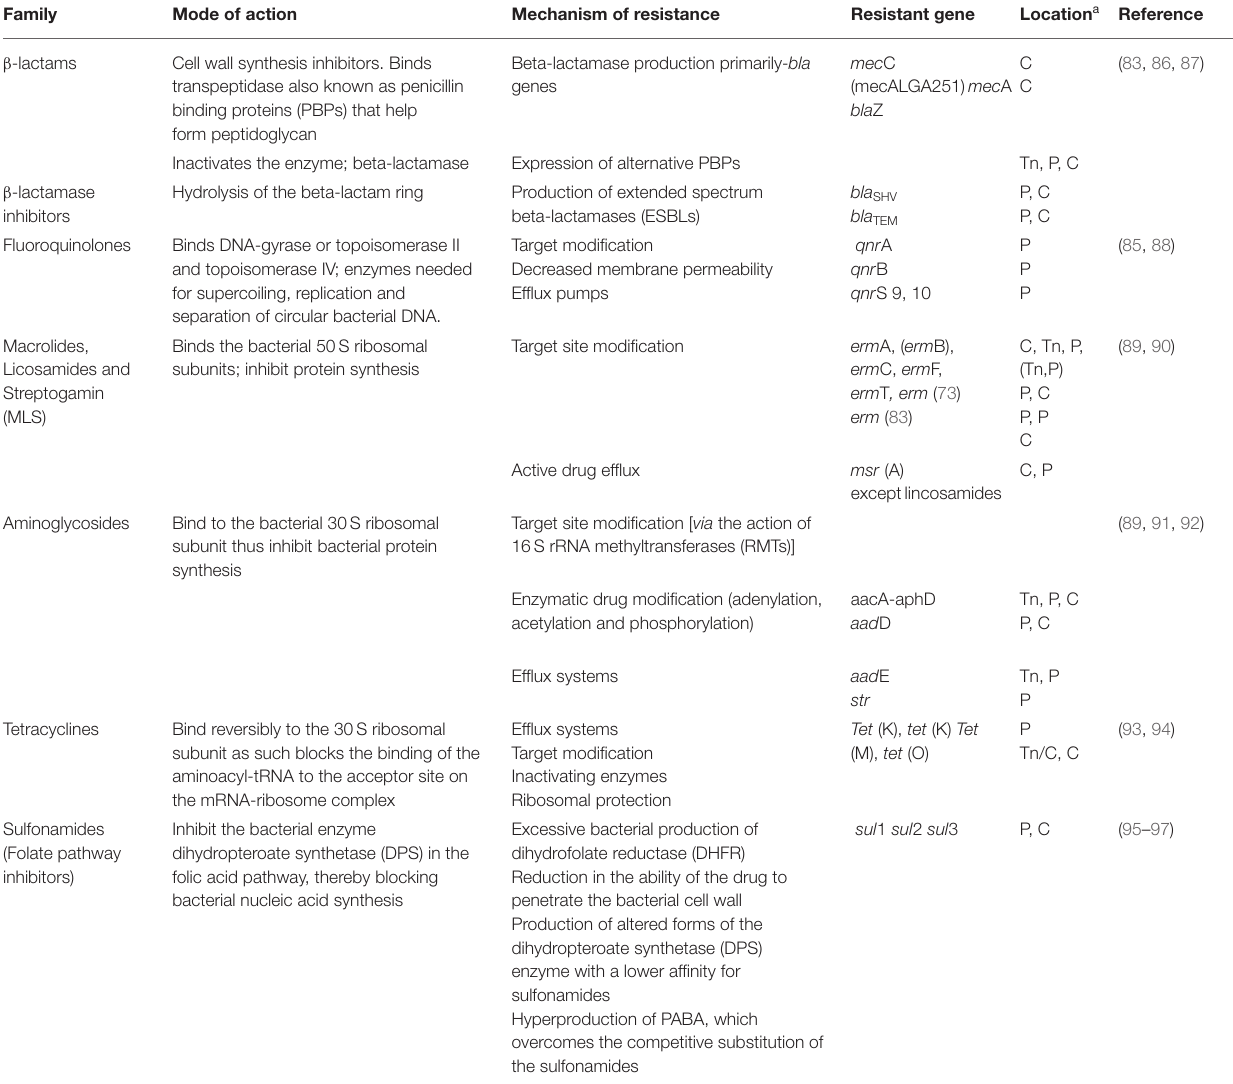
TABLE 1 | Mode of action, mechanisms of resistance of antibiotics and some antimicrobial resistance genes (ARG) of animal origin. Family Mode of action Mechanism of resistance Resistant gene Location a